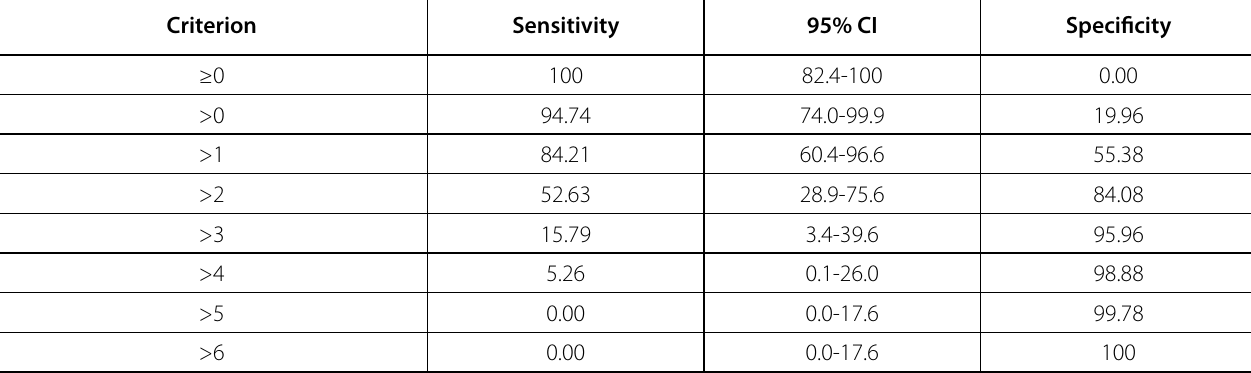
DS -VASc to predict MACE. 2 2